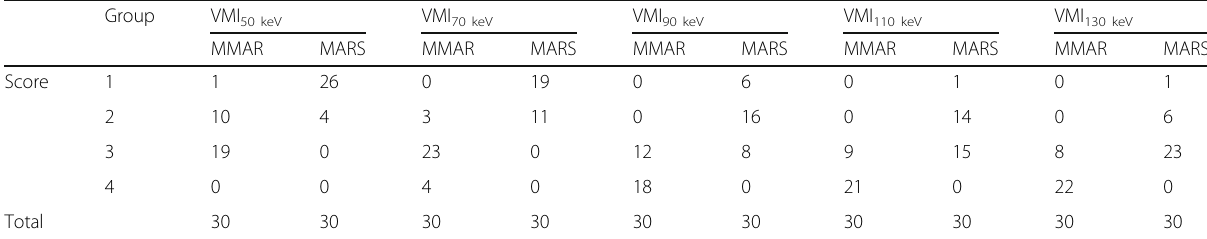
Table 3 Image quality at different energy